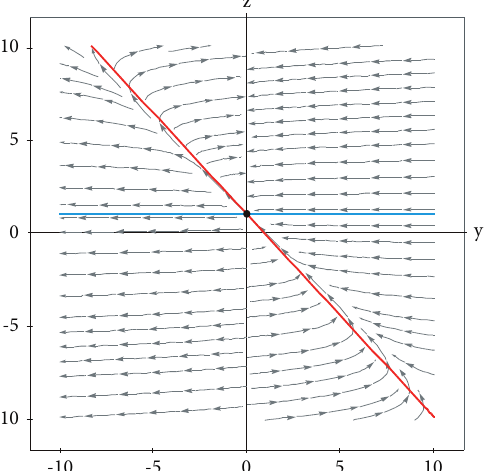
Figure 11: Phase plane of system (9), for the case where R � 1/ σ ≃ 5 . 882 ( β ′ � 1 . 005 ) ; the other rates are δ � 0 . 071, α � 0 . 1, and σ � 0 . 17. The 0 vector field and some trajectories are indicated by lines and arrows in gray. Two nullclines are shown: one horizontal (blue line) and other vertical (red line); the horizontal and vertical remaining pair coincides with the z -axis. The disease-free equilibrium point E endemic E ∗ coincide at the point ( 0 , 1 ) , the latter being a doubly degenerate equilibrium; such points are indicated by a black